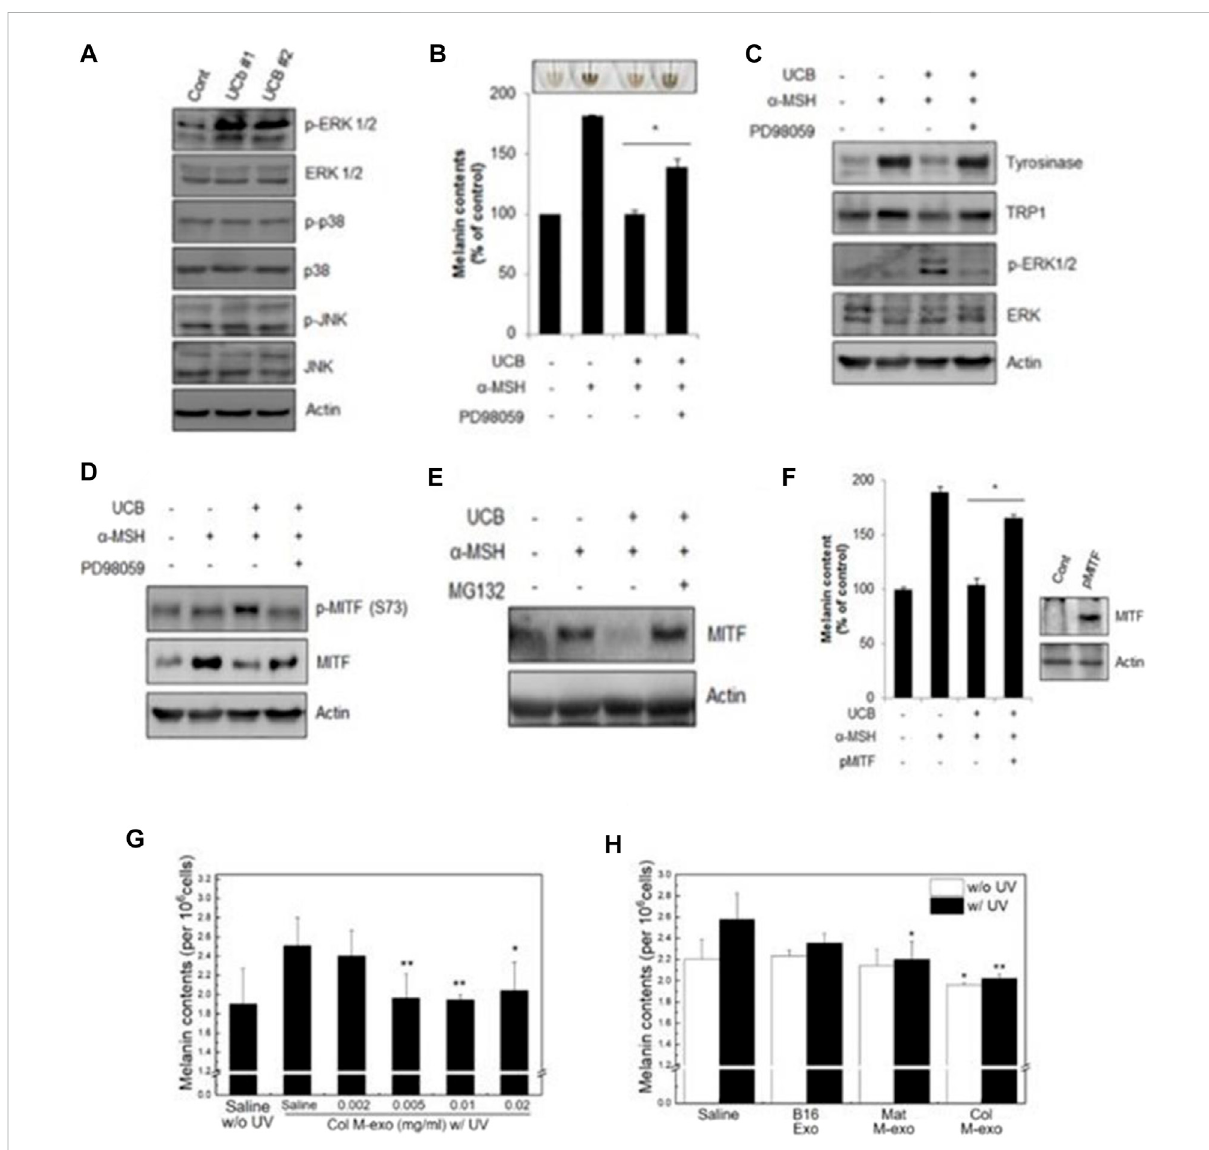
FIGURE 8 Exosomesinhibitmelaninproduction. (A – C) Westernblotwasusedtoanalyzetheexpressionofrelatedproteins.Melanincontentincellsunder different conditions.Western blot analysis of protein expression levels of tyrosinase, TRP1, p-ERK1/2 and ERK1/2 in cells. (D – F) Western blot analysis was used to detect the level of MITF under different conditions (Kim et al., 2015). (G, H) Melanin content of UV irradiated cells under different conditions (Han et al.,